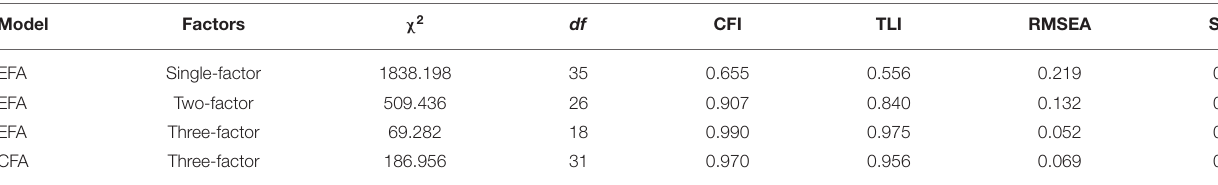
TABLE 3 | EFA and CFA fitting indexes of the C-BASIC-Q.